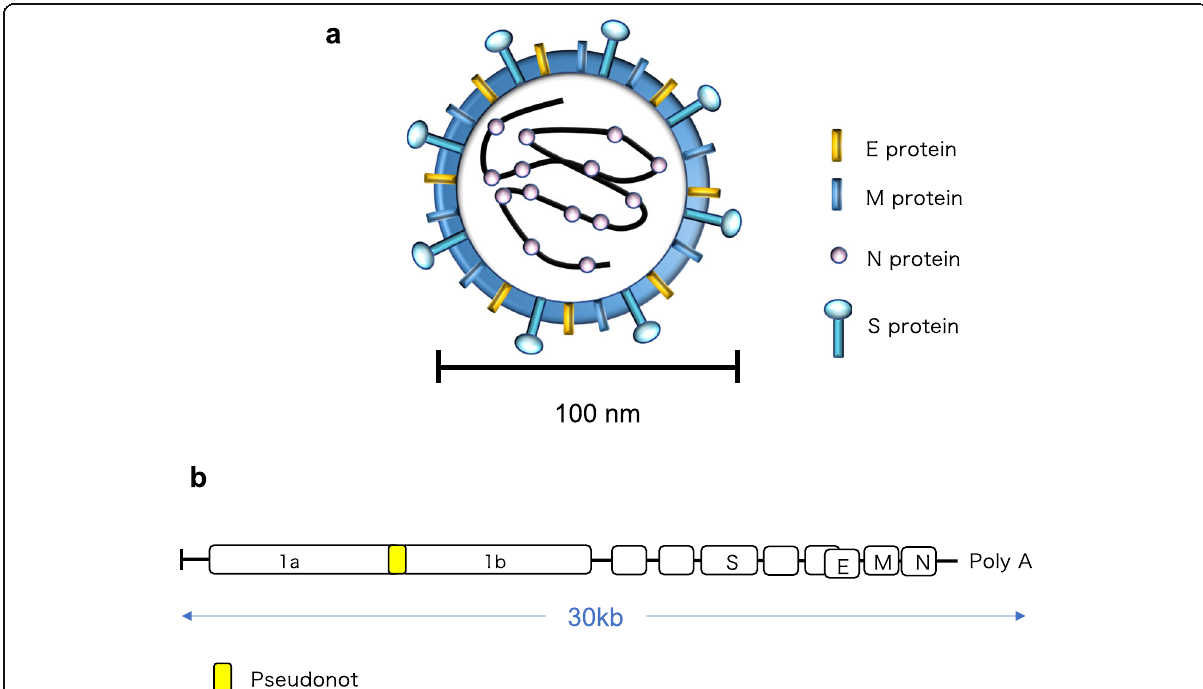
Fig. 1 Schematic diagram of the coronavirus structure and genomic structure. a The coronavirus genome is single-stranded RNA, which together with nucleocapsid (N) protein constitutes the nucleocapsid. There is an envelope that encloses the nucleocapsid, which consists of spike (S) protein, integral membrane (M) protein, and envelope (E) protein. b ORF1a and ORF1b continue to exist from the 5' end to approximately 20 kbp. Since the pseudoknot structure exists between the two, two patterns of translation products of the 1a region or 1a + 1b region are generated. Other ORFs encode S protein, E protein, M protein, N protein,